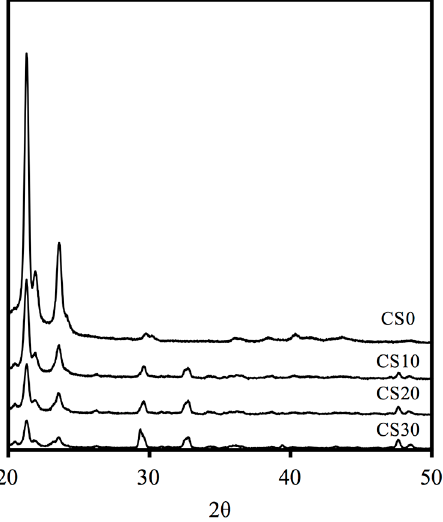
Figure 1. XRD patterns of the various Mg–CS content of 3D scaffolds.